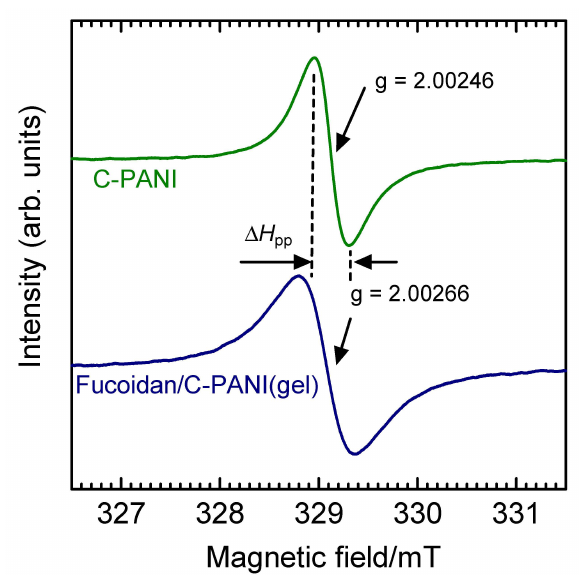
Figure 14. Electron spin resonance (ESR) line shapes of C-PANI (green line) and fucoidan/C- PANI(gel) (blue line).